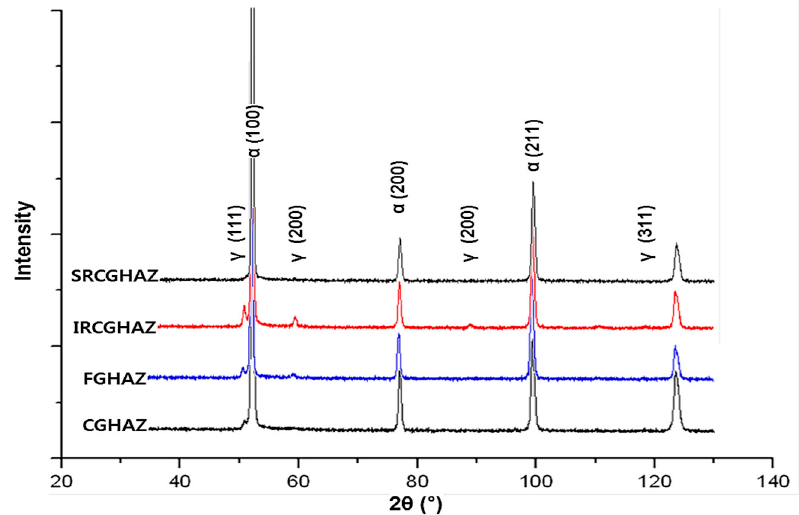
Figure 5. XRD patterns of each simulated HAZ.